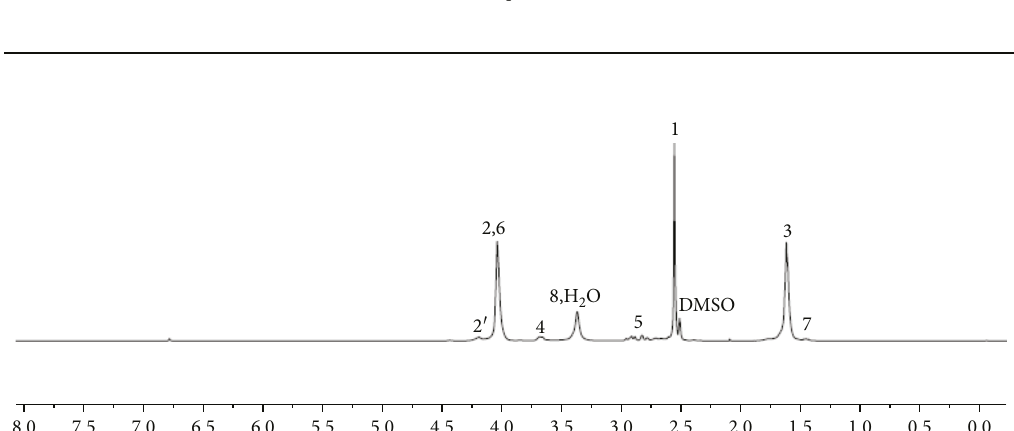
Ss 301 H NMR spectrum (400MHz, 70